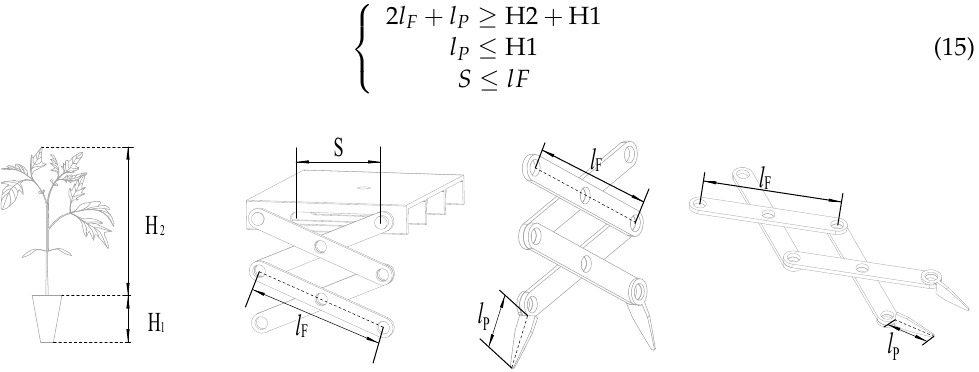
Figure 6. Schematic diagram of seedling height and the size of the part.